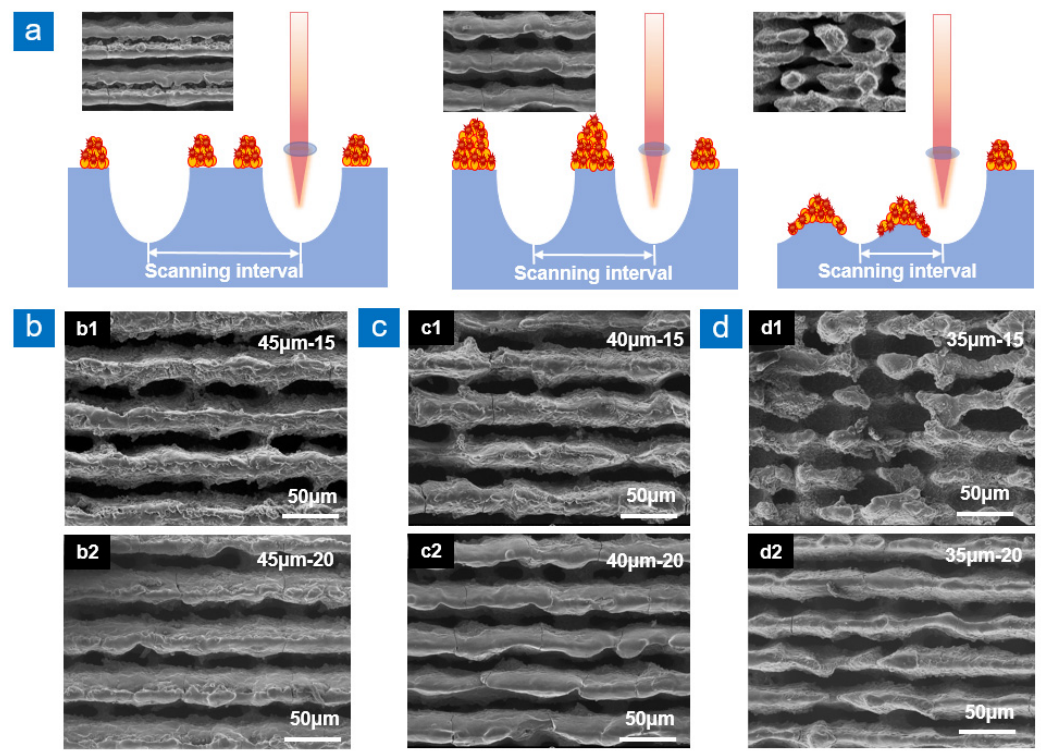
Figure 2. Influence of different scanning intervals on the morphology of recast layer at two sides of groove. ( a ) Schematic diagram of the influence of scanning intervals on recast layer, ( b ) SEM images of TC4 with scanning times of 15(b1) and 20(b2) when the scanning interval is 45 μ m, ( c ) SEM images of TC4 with scanning times of 15(c1) and 20(c2) when the scanning interval is 40 μ m, ( d ) SEM images of TC4 with scanning times of 15(d1) and 20(d2) when the scanning interval is 35 μ m.